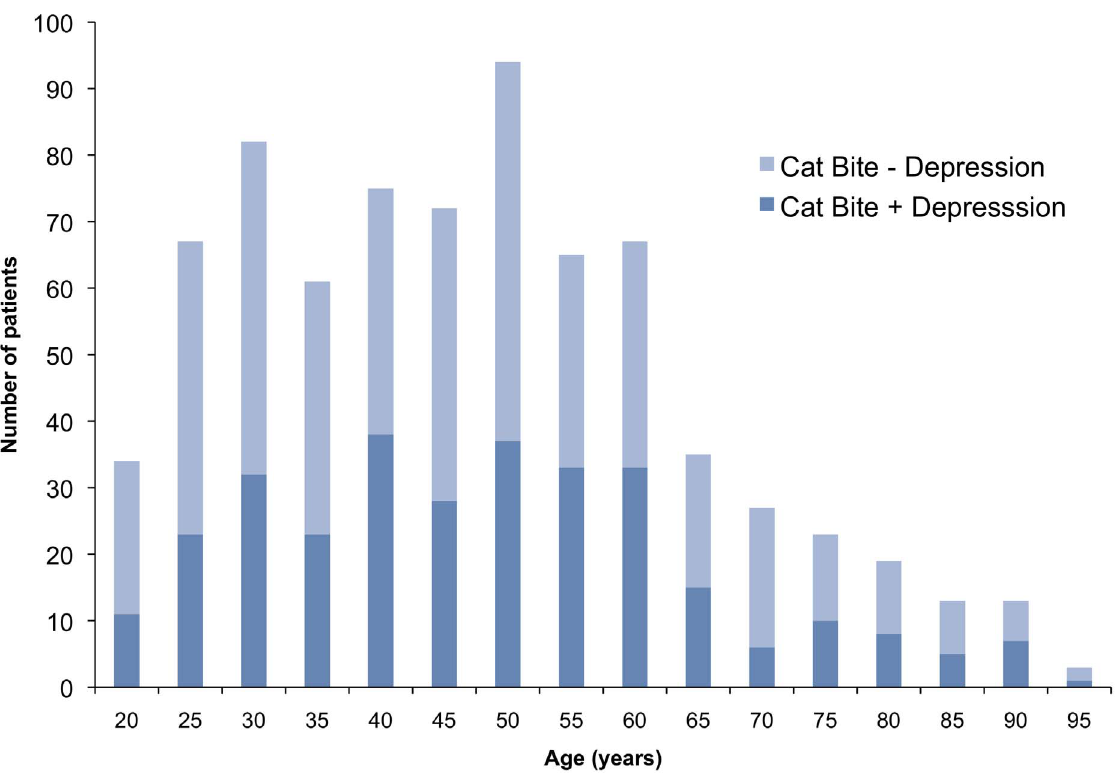
Figure 1. Stacked bar chart showing age versus total number of patients, for 750 patients with cat bites. Dark blue bars represent patients with depression and light blue bars represent patients without depression. Ages are rounded to the nearest 5-year period.